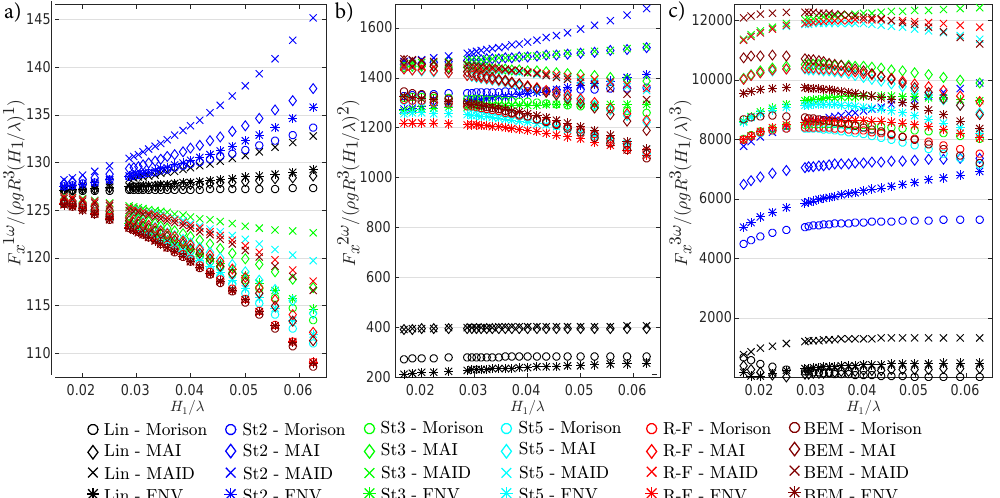
Figure 6. First ( a ), second ( b ) and third ( c ) harmonics of the normalized horizontal force over the increasing wave steepness H 1 / λ . Corresponds to the experimental cases by Kristiansen and Faltinsen (2017) [24] with T = 2.021 s in the depth h = 0.564 m